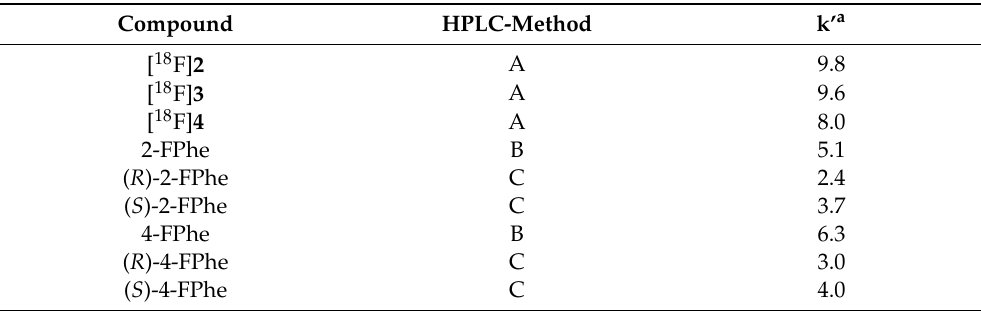
Table 4. Retention factors (k’)a of the reference